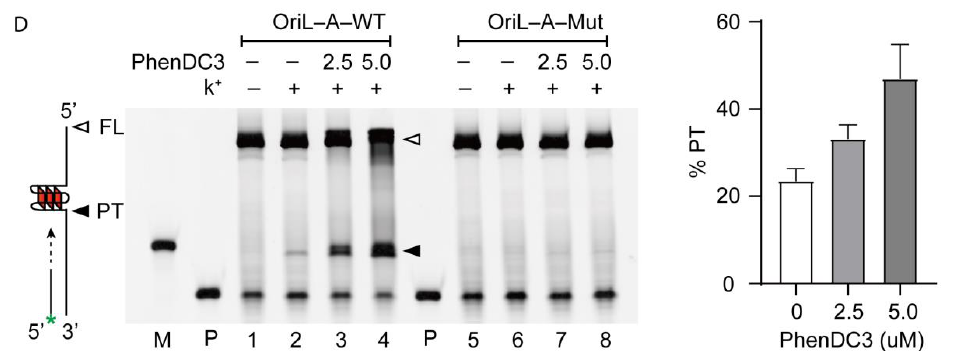
Figure 2. PhenDC3 binds and stabilizes G4 formed in OriL-S and OriL-A. ( A , B ) Fluorescence melting curve of OriL-S and